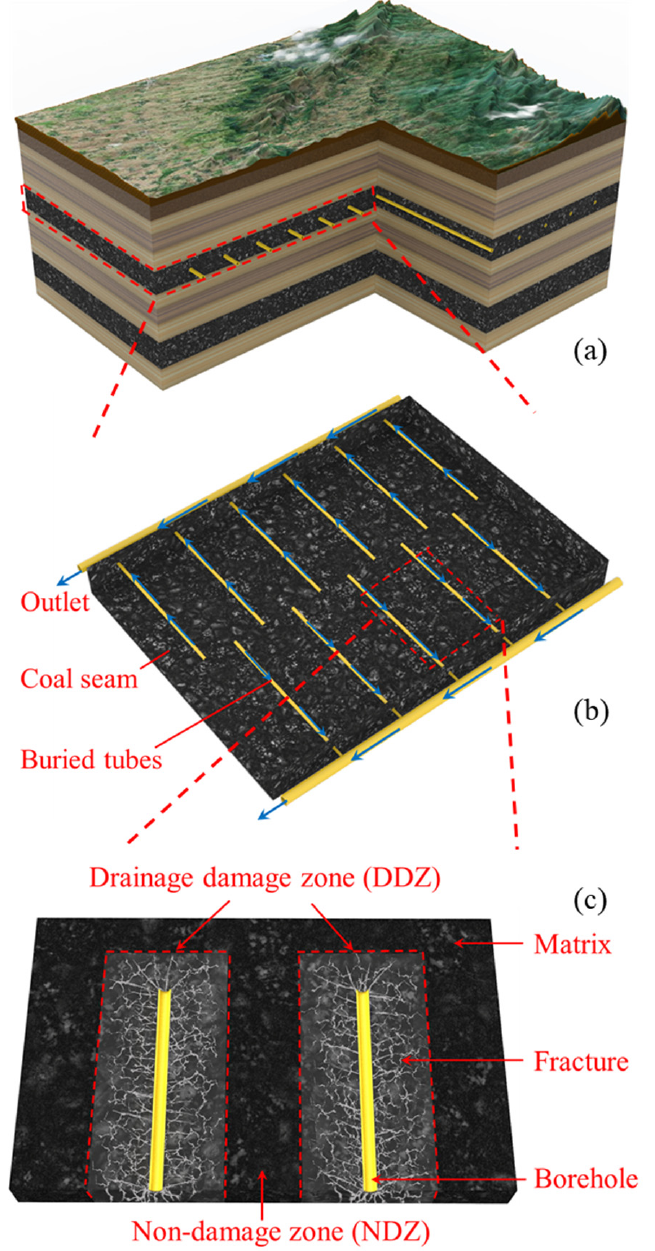
Figure 1. Schematic diagrams (( a ) gas extraction in coal seam; ( b ) the process of gas extraction; ( c ) DDZ and NDZ).